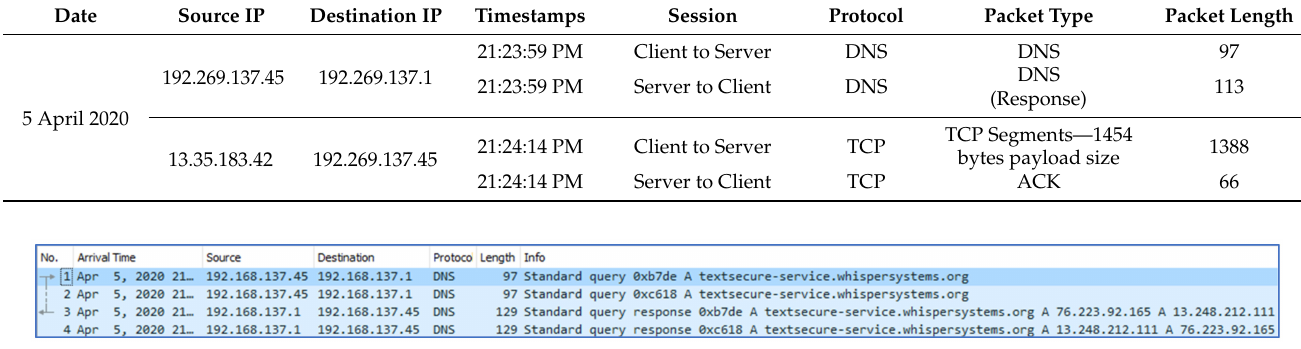
Table 8. Temporal analysis of a particular incident.